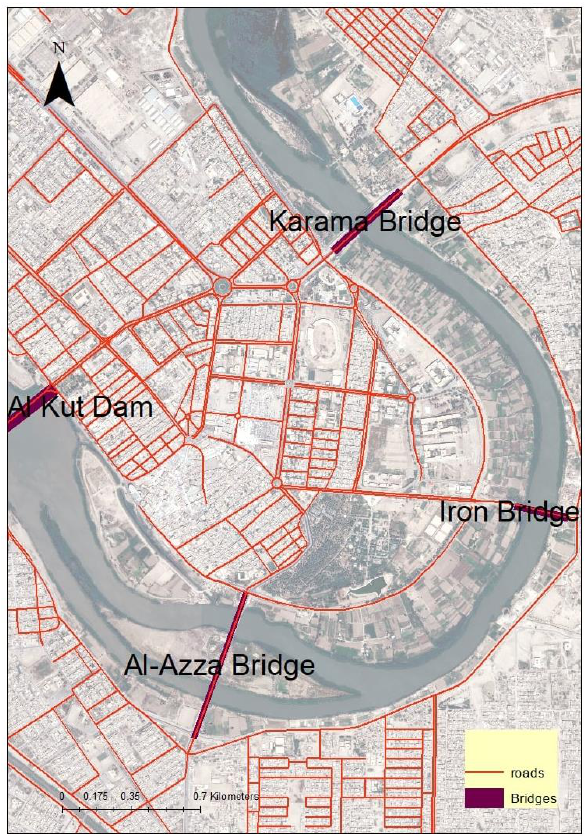
Fig. 5. Transit lines that start from the terminal in the study